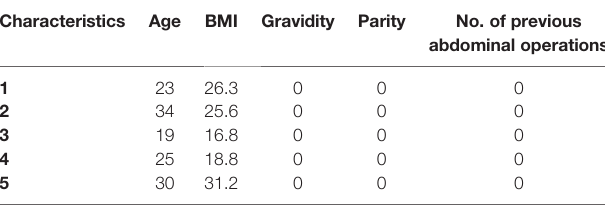
TABLE 1 | Clinical characteristics of the fi ve patients. Characteristics Age BMI Gravidity Parity